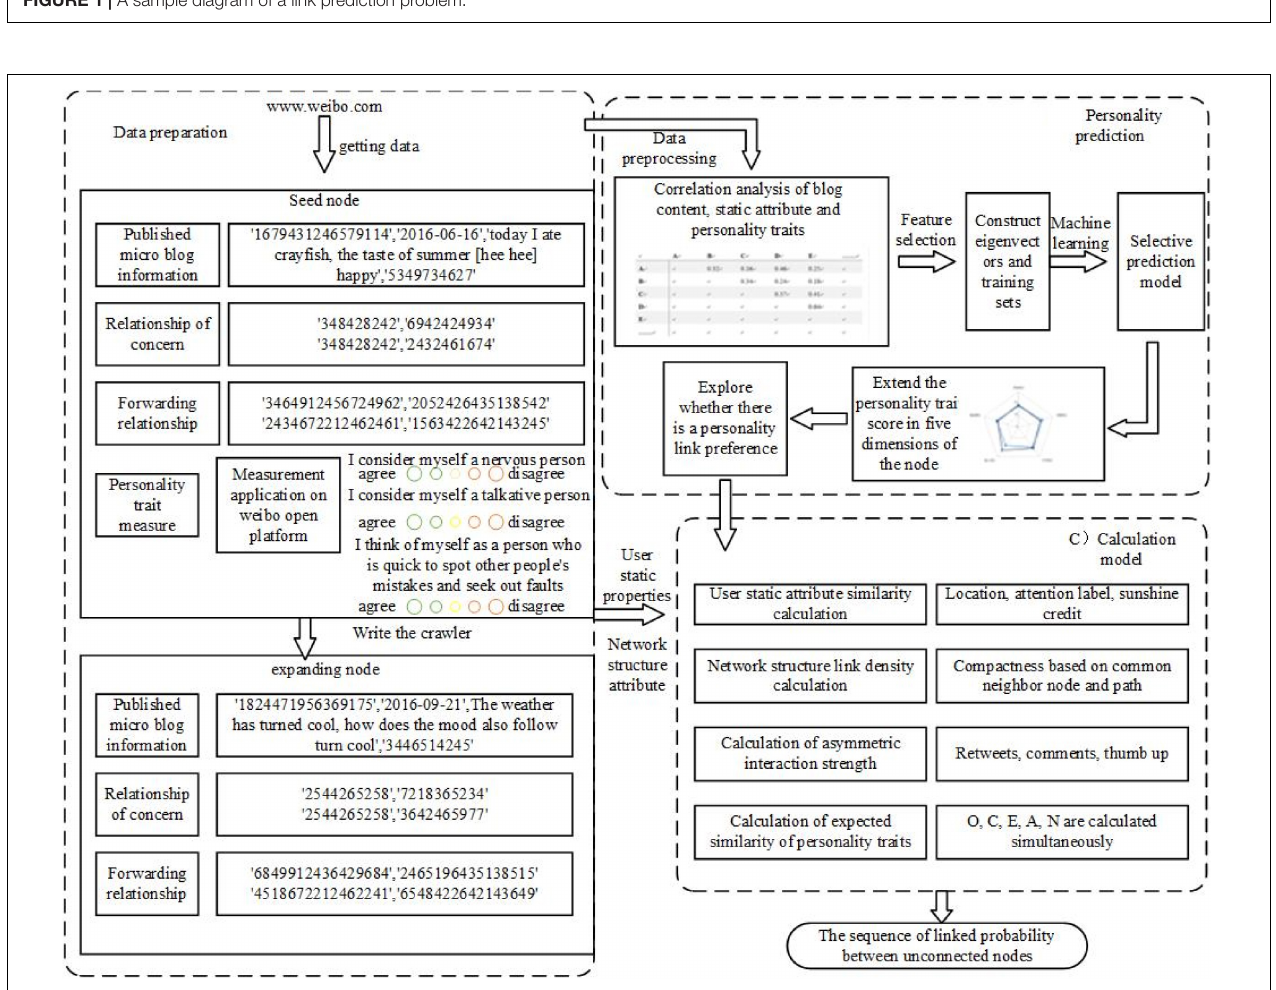
FIGURE 1 | A sample diagram of a link prediction problem.